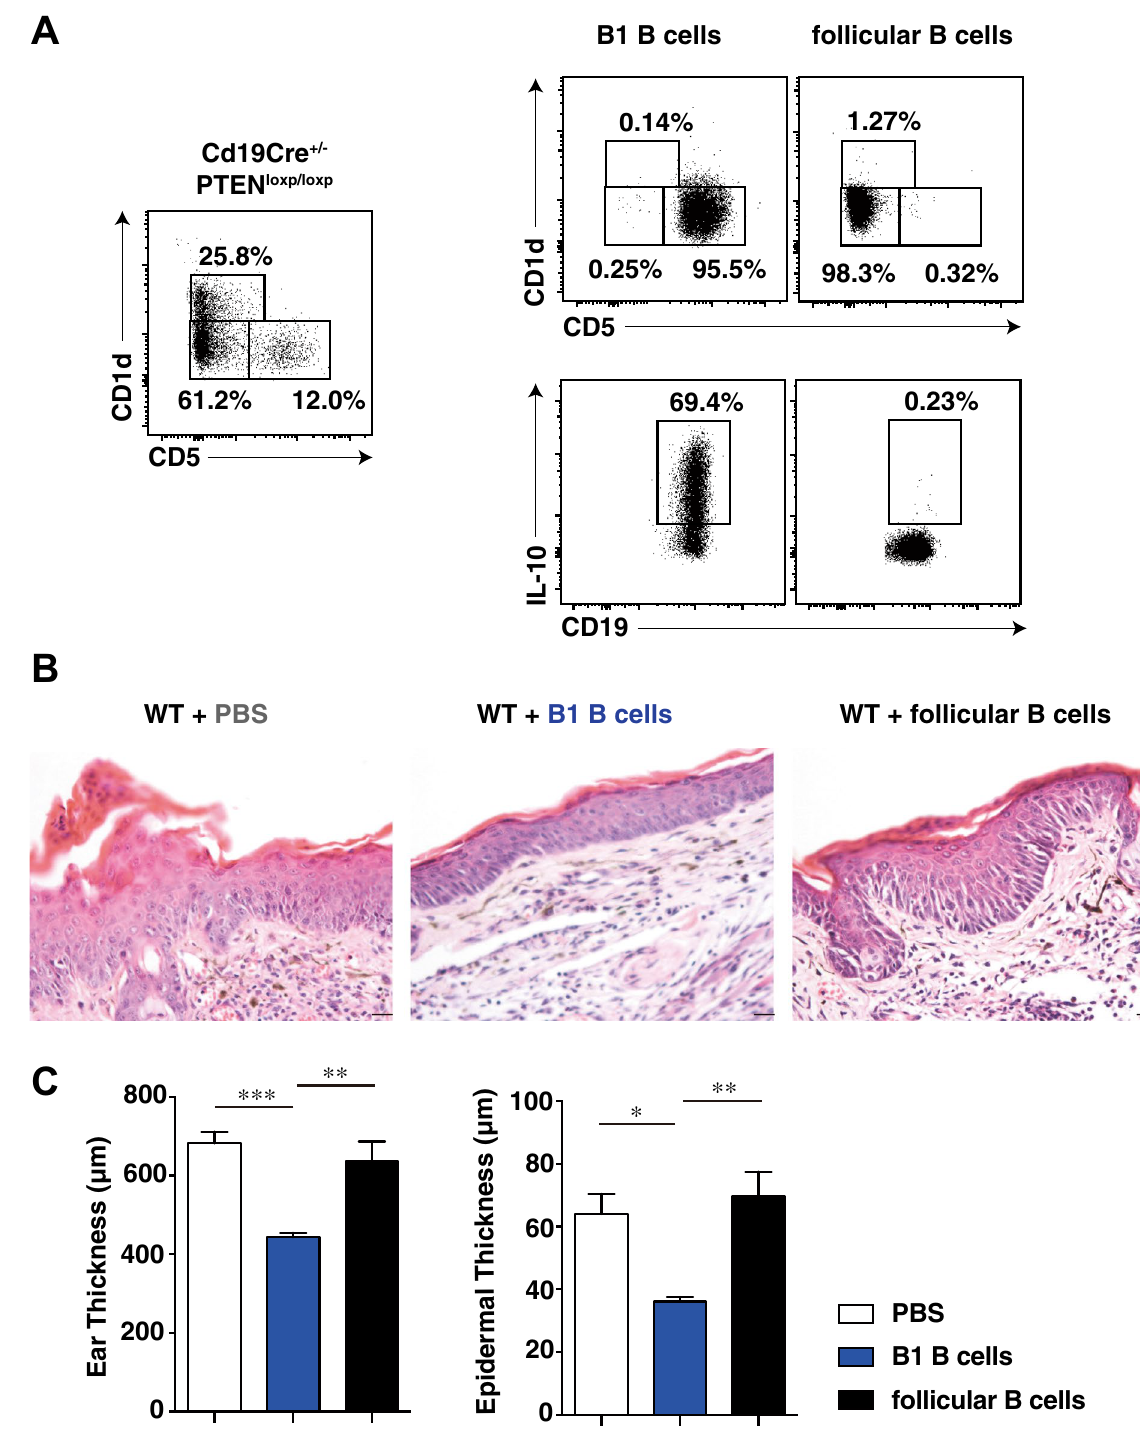
Figure 6. Adoptive transfer of B1 B cells suppressed IL-23-mediated psoriasis-like inflammation. ( A ) Splenic B cells from Cd19Cre + /− Pten loxP/loxP mice were isolated, stained for CD1d, CD5, and CD19 expression; and sorted into CD1d int CD5 + B1 B cells and CD1d int CD5 - follicular B cells before stimulation with a mixture of LPS, PMA, ionomycin, and brefeldin-A for 5 h. IL-10 + B cells derived from each purified population were analyzed using flow cytometry. ( B ) Isolated splenic B cells (1 × 10 6 cells) from Cd19Cre + /− Pten loxP/loxP mice were transferred into WT mice before rmIL-23 injection. H&E staining of skin section from ears in WT mice (original magnification × 20; bars = 20 μm). ( C ) Effect of adoptive transfer of B1 B cells on ear thickness and epidermal thickness. The images were created with FlowJo software (version 10.1R5; Tree Star, San Carlos, CA, USA, https ://www.flowj o.com/). Values represent means ± SEMs (n = 10 mice/group). Significant differences between samples means are indicated as: * P < 0.05, ** P < 0.01, *** P <